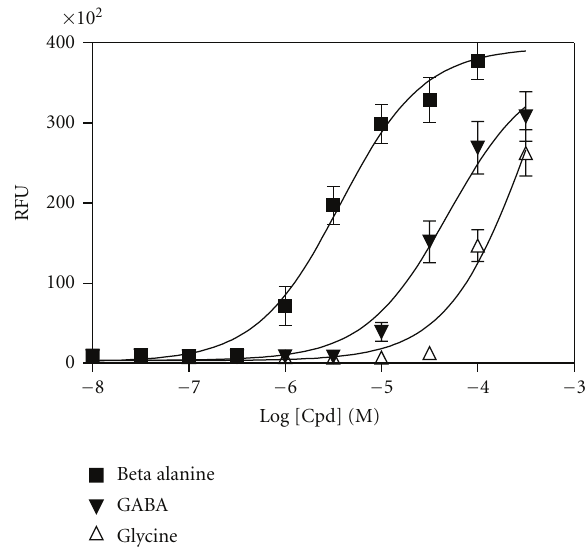
Figure 1: Concentration response for beta-alanine, GABA, and glycine on rat MrgD receptor in CHO-DUKX cells. Representative data from calcium mobilization FLIPR assay performed in 384 wells are shown. Each data point represents mean of 32 replicates, and error bar represents SD. Human MrgD expressing CHO-DUKX cells also had similar dose response (data not shown).